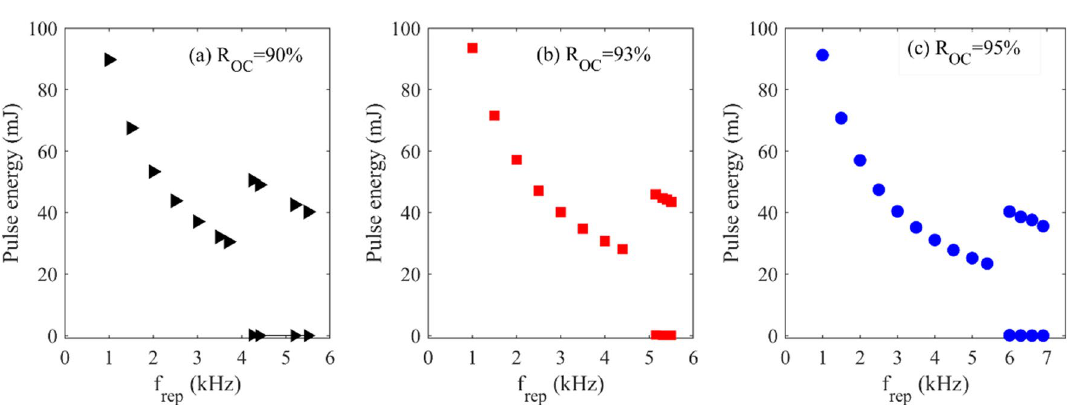
Figure 4. Numerical prediction of energy of the pulses in the pulse train versus the repetition rate for a pump power of 520 W and three different OC